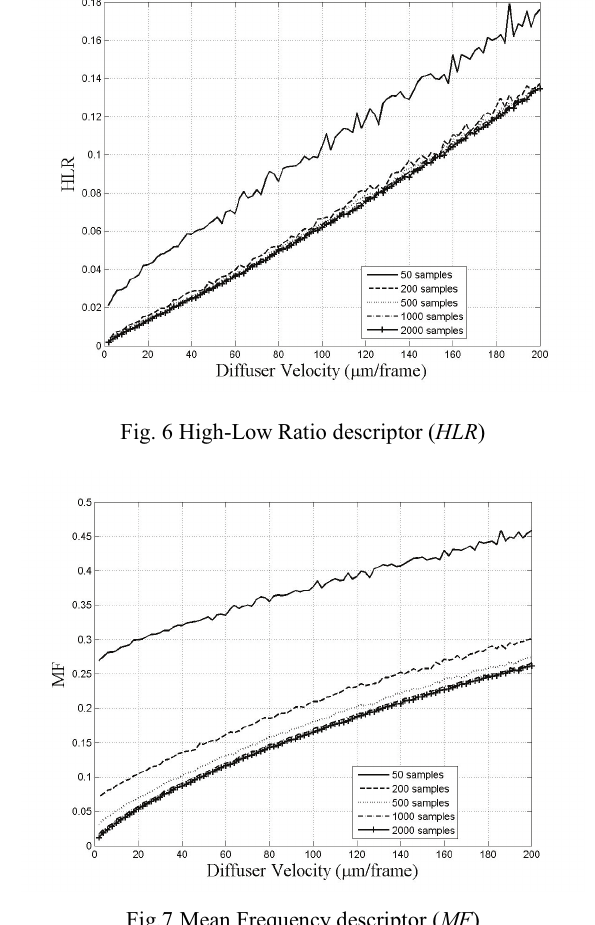
Fig.7 Mean Frequency descriptor ( MF )